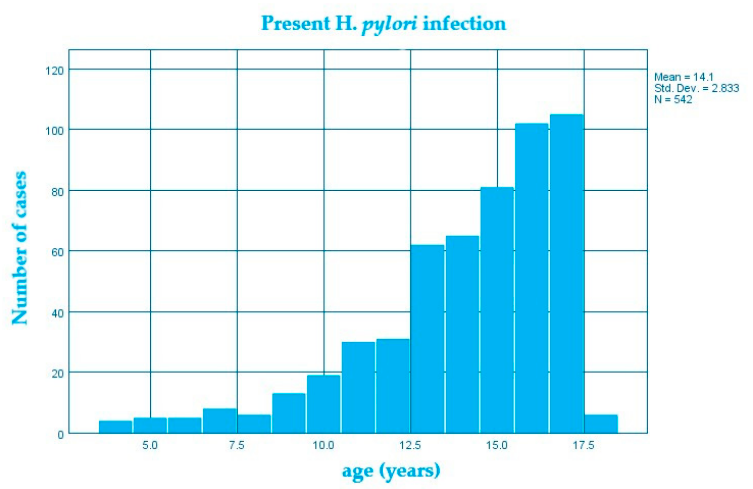
Figure 2. Structure of the group of patients with H. pylori infection by age (years).